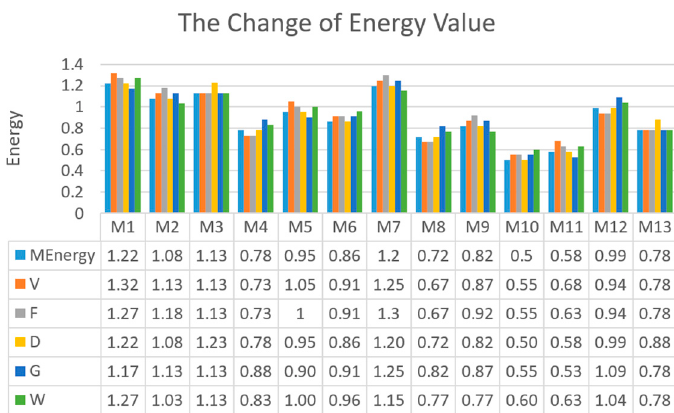
Figure 15. The change of Energy value in Memory Capsule by Qualia Matching with V, F, D, G and W.